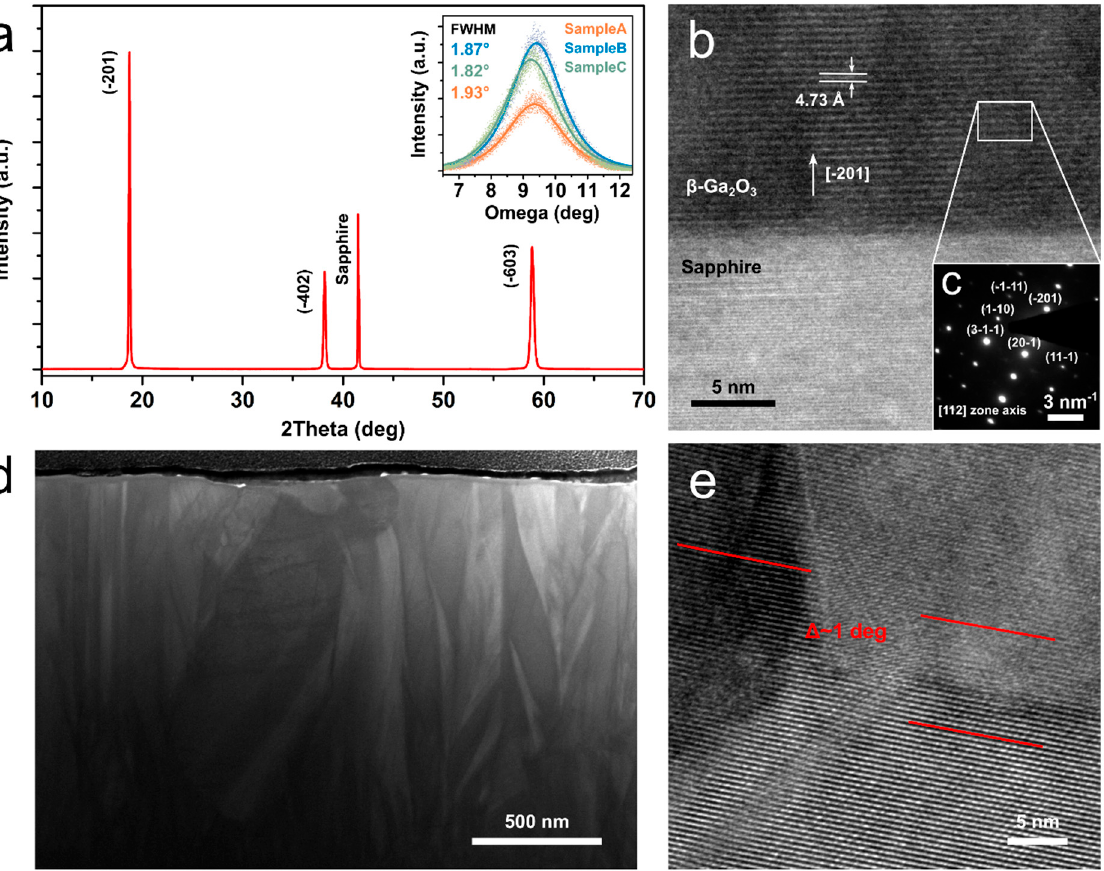
Figure 3. ( a ) A typical X-ray diffraction pattern of a Ga 2 O 3 film on c-plane sapphire, all samples gave qualitatively similar patterns. The inset shows rocking curves ( ω -scans) of the ( − 201) peak of the studied samples. ( b ) A transmission electron microscope image of the Ga 2 O 3 /sapphire interface in Sample C, showing the Ga 2 O 3 growth direction and interplanar spacing, with ( c ) selected area electron diffraction pattern of the Ga 2 O 3 film. ( d ) Scanning electron image of the cross-section cut of Sample C. ( e ) An example of a low-angle grain boundary typically observed in Sample